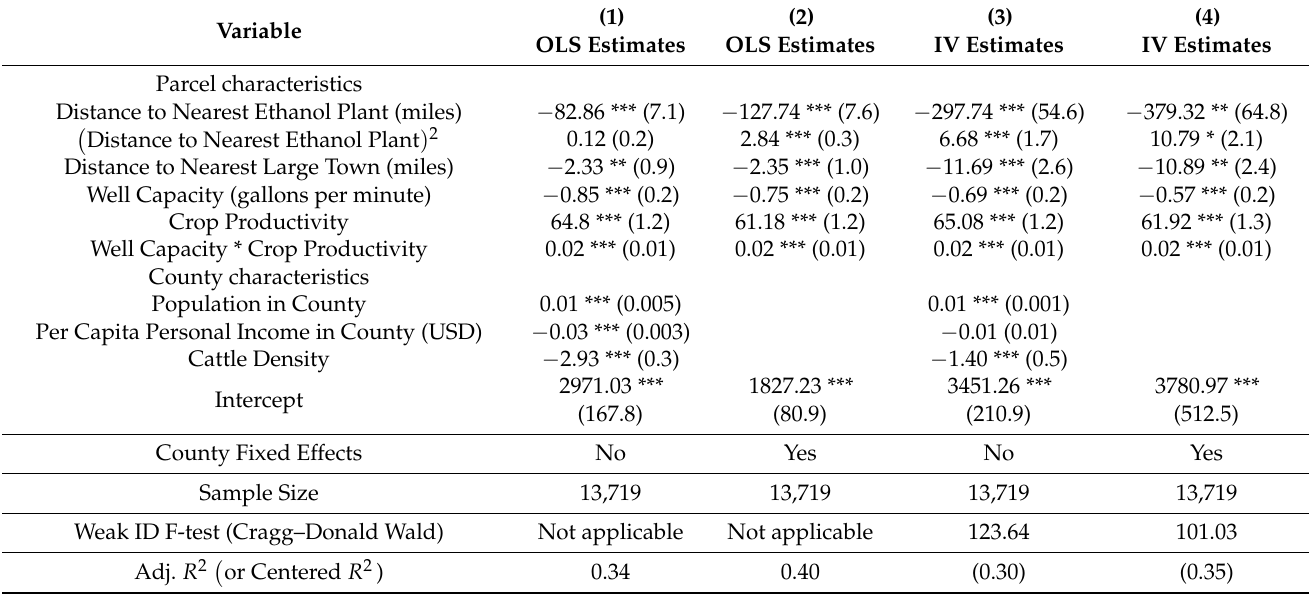
Table 2. Hedonic estimates of effect of proximity to ethanol plants on farmland values